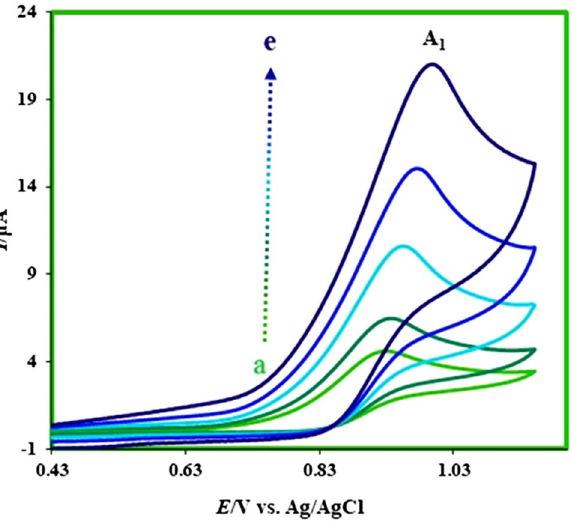
Figure 6. Cyclic voltammograms of MFA (1.0 mM) at glassy carbon electrode in ethanol containing MgClO 4 (1.0 M) in various scan rates. Scan rates from a to e are: 5, 10, 25, 50, and 100 mV/s. Room temperature.